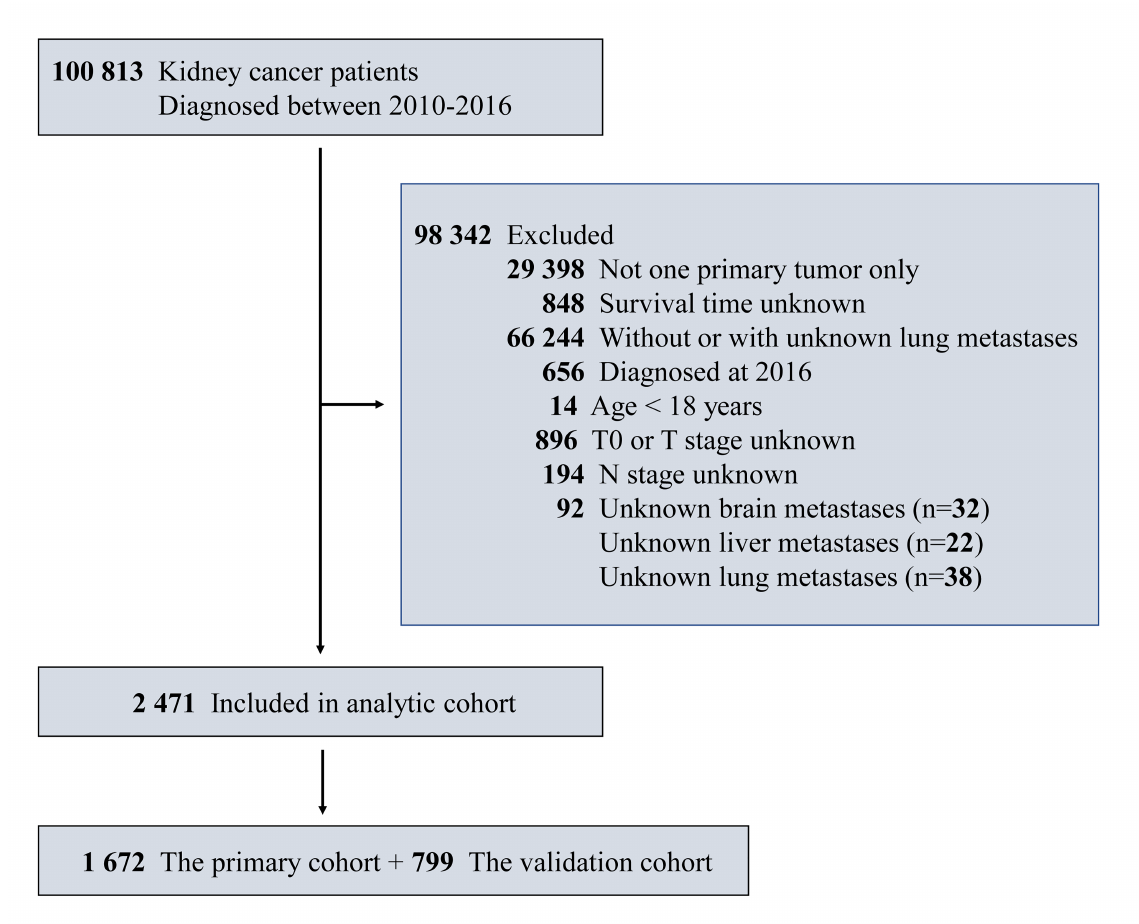
Figure 1 - Study design flowchart of specific patient screening